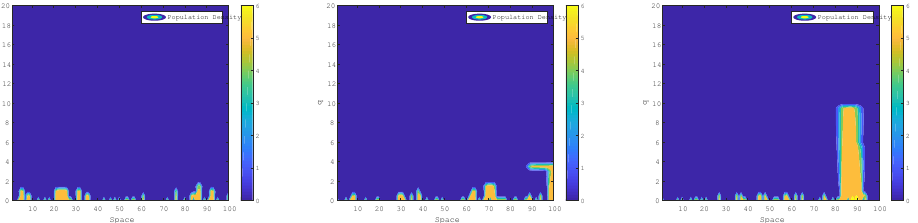
Figure 10. Stationary metapopulation distributions over space as a function of q obtained for the first type initial conditions (15), β = 6, and three random realizations of the carrying capacity ( left to right ): k ( 1 ) , k ( 2 ) and k ( 3 ) , respectively.